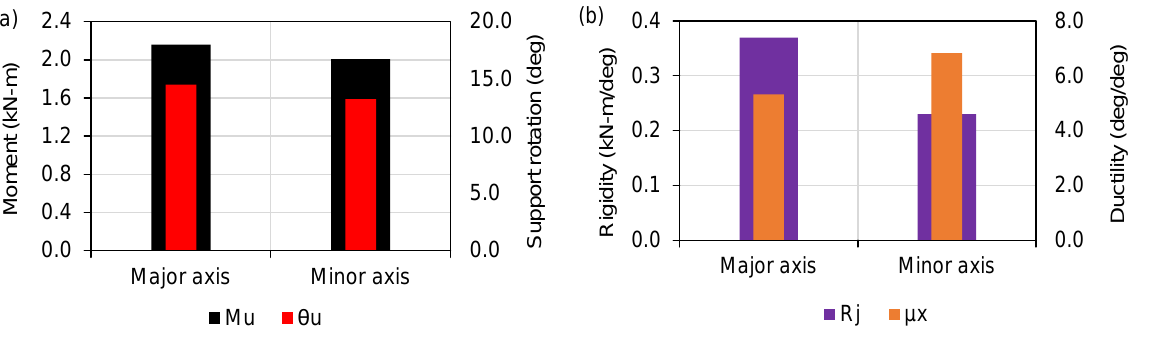
Figure 14. Failure modes of ( a ) glued and bolted plywood, ( b ) unglued and bolted plywood and ( c ) 8mm-thick steel spline connection.